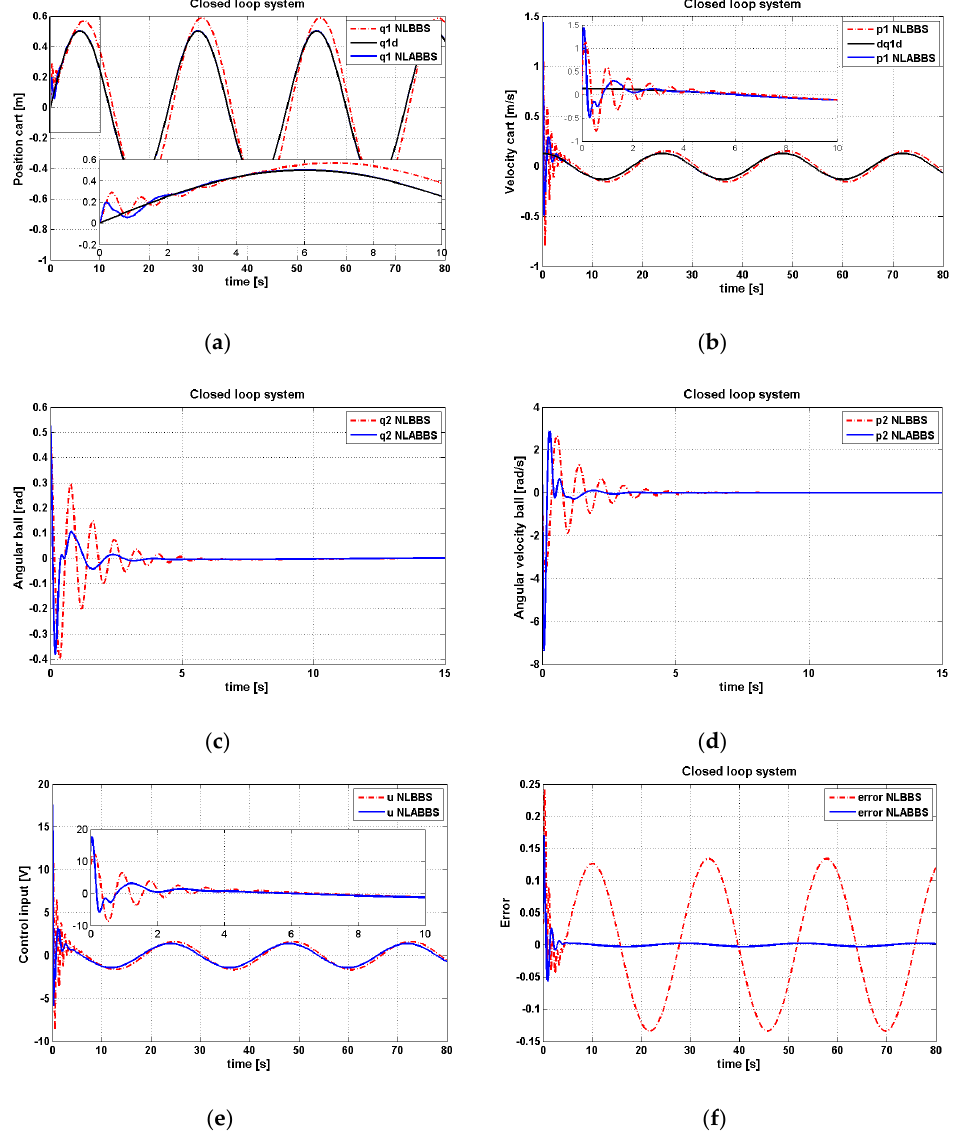
Figure 7. Dynamic Responses of different state variables and control signals for the systems based on the adaptive and conventional block-backstepping controllers: ( a ) cart displacement; ( b ) cart linear velocity; ( c ) ball angular position; ( d ) ball angular velocity; ( e ) control signals; ( f ) error between the actual and desired positions of the cart. Table 5. Tracking performance of the ball–arc system based on the controllers.